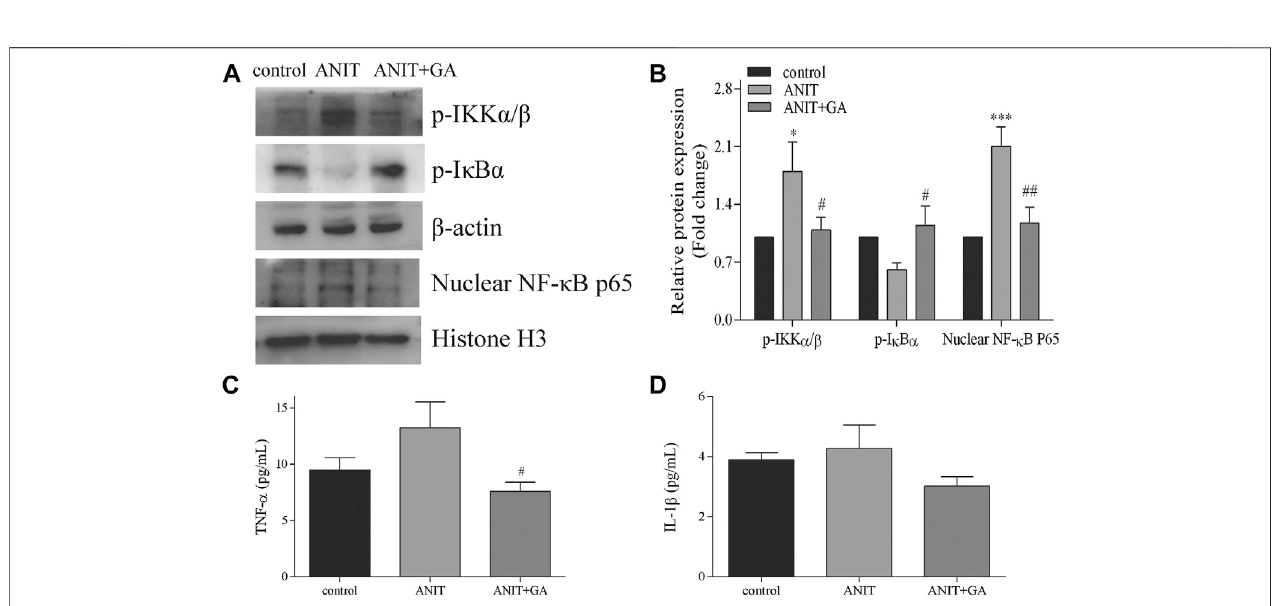
FIGURE6| EffectsofGAontheexpressionofNF- κ Bsignalingpathway. (A) EffectsofGApretreatedontheproteinexpressionofp-IKK α / β ,p-I κ B α andNF- κ Bp65 after ANIT treatment. (B) The quantitative densitometric analysis of the protein bands ( n (cid:1) 6) (C – D) Serum contents of TNF- α and IL-1 β ( n (cid:1) 6 – 7).